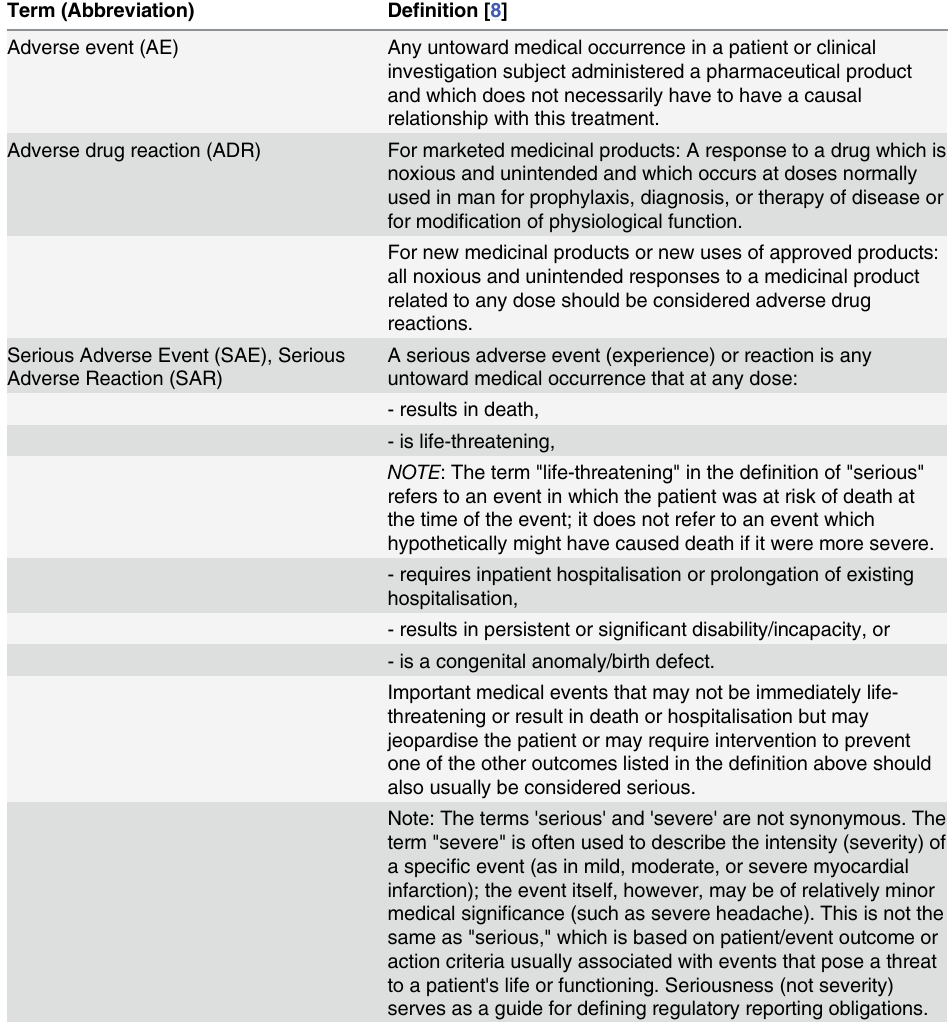
Table 1. Adverse event terminology and